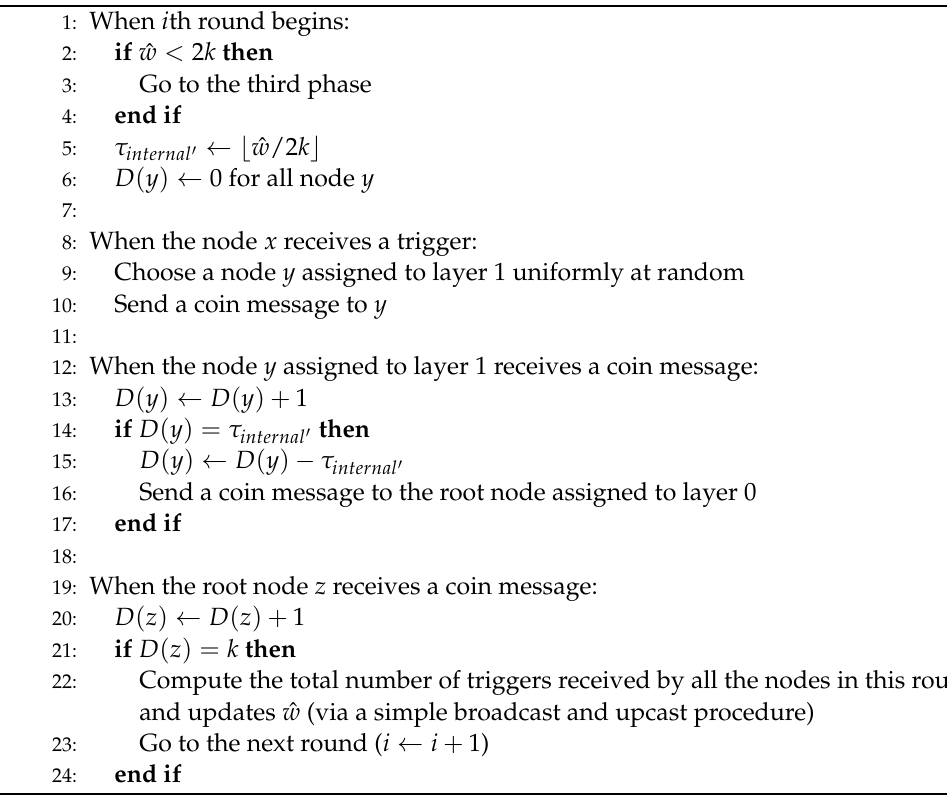
Algorithm 2: The second phase of the proposed algorithm